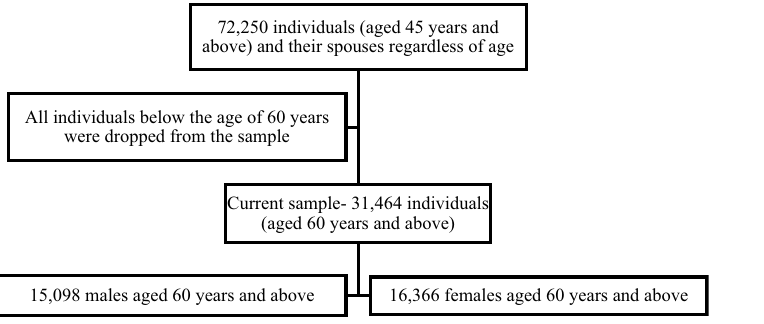
Figure 1. Flowchart for the study sample